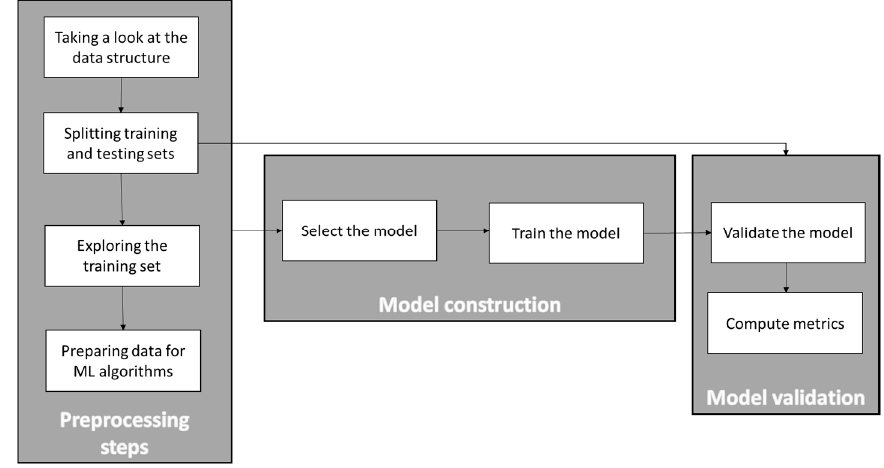
Figure 1. Main steps of a machine learning process (preprocessing–model construction–model validation).